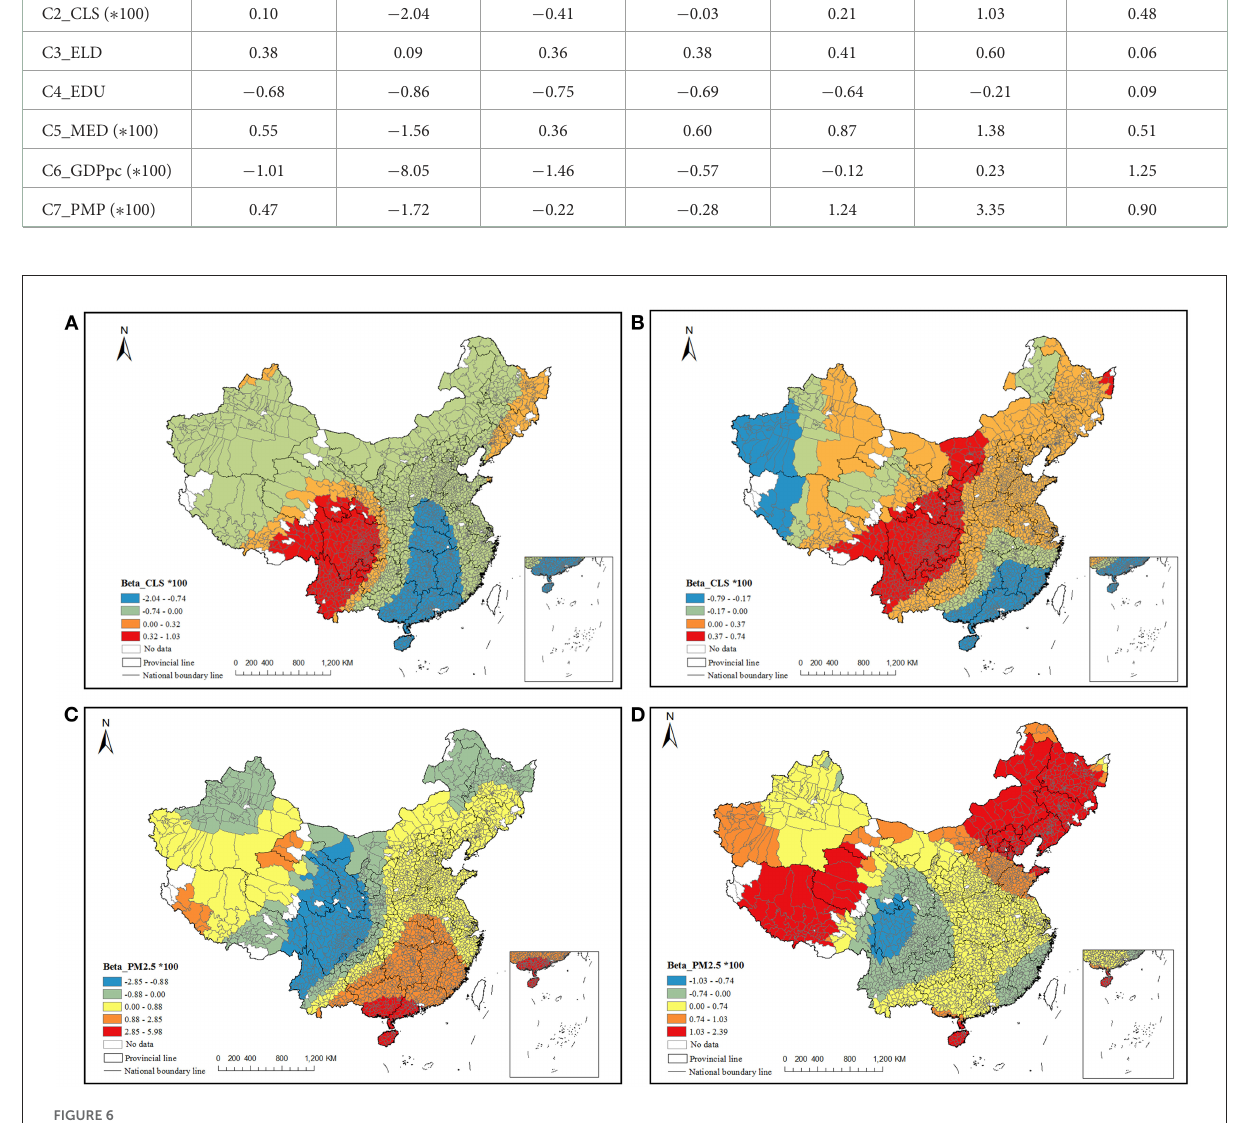
FIGURE6 The local non-stationary influence of CLS and PM 2.5 on mortality (A, C) 2000 (B, D)